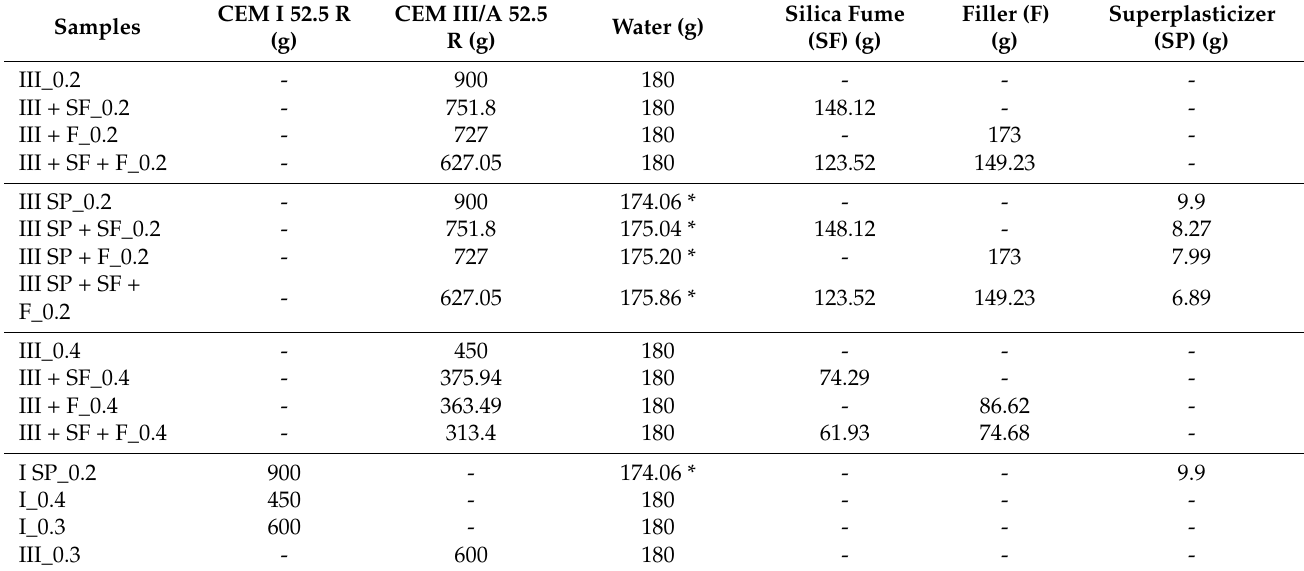
Table 1. Cement pastes